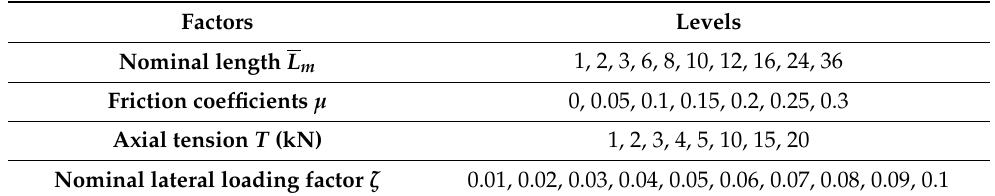
Table 3. Factors and levels for parametric